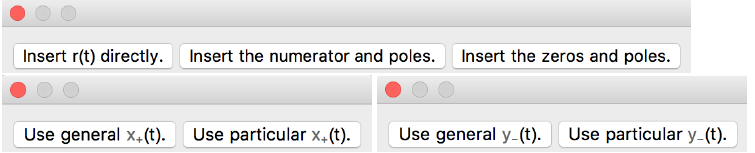
Figure 57. Part of the code structure of the [SInt] 2.0 algorithm responsible for the input options.